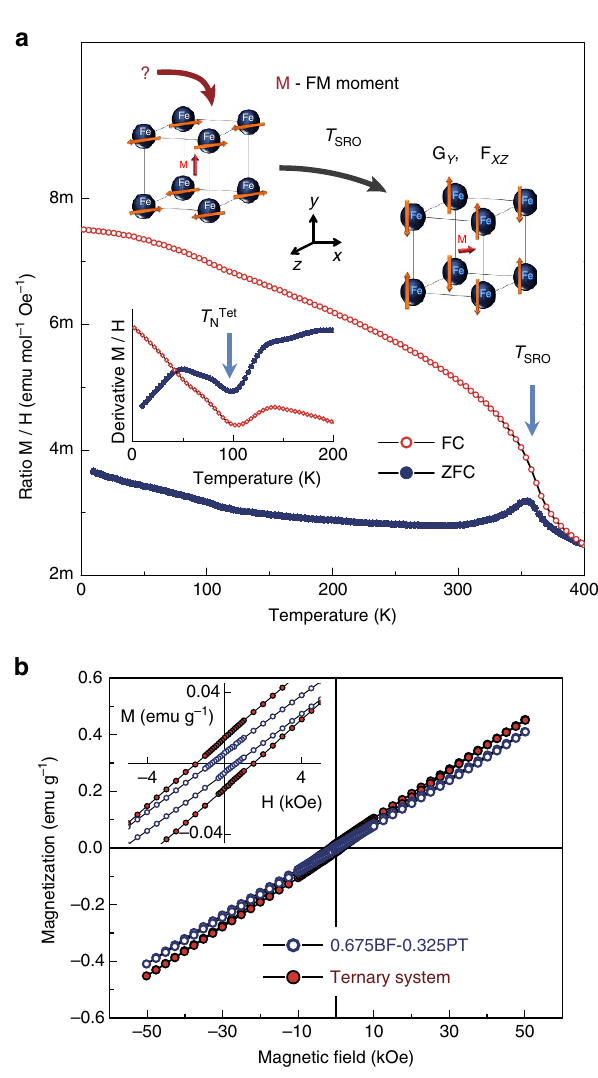
Figure 3 | Magnetic properties. ( a ) Zero-field-cooled (ZFC)/Field-cooled (FC) magnetization curves for the Bi 0.68 Pb 0.32 Fe 0.655 Mn 0.025 Ti 0.32 O 3 ceramic under a dc magnetic field of 500Oe. The magnetic anomaly at 360K is associated with a spin-reorientation phenomenon ( T SRO ) within the Cc phase (Inset shows a schematic description of the proposed magnetic structure involved in the SRO in terms of ferromagnetic F and antiferromagnetic G components 39 , M stands for the ferromagnetic (FM) moment. Derivative curves highlights the Ne´el temperature ( T N Tet ) at B 100K of the P 4 mm phase. ( b ) Isothermal magnetization loop recorded at 300K for the ceramic under study (ternary system) and that for the MPB composition of the binary system (0.675BiFeO 3 –0.325PbTiO 3 ) for